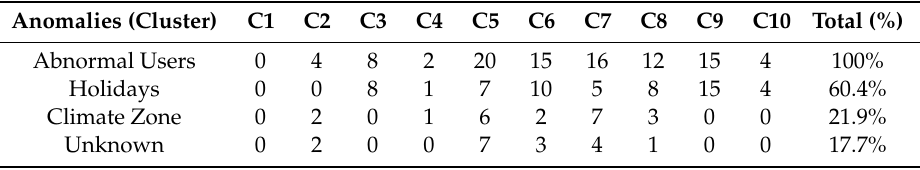
Table 4. Abnormal user detection details of each cluster based on possible